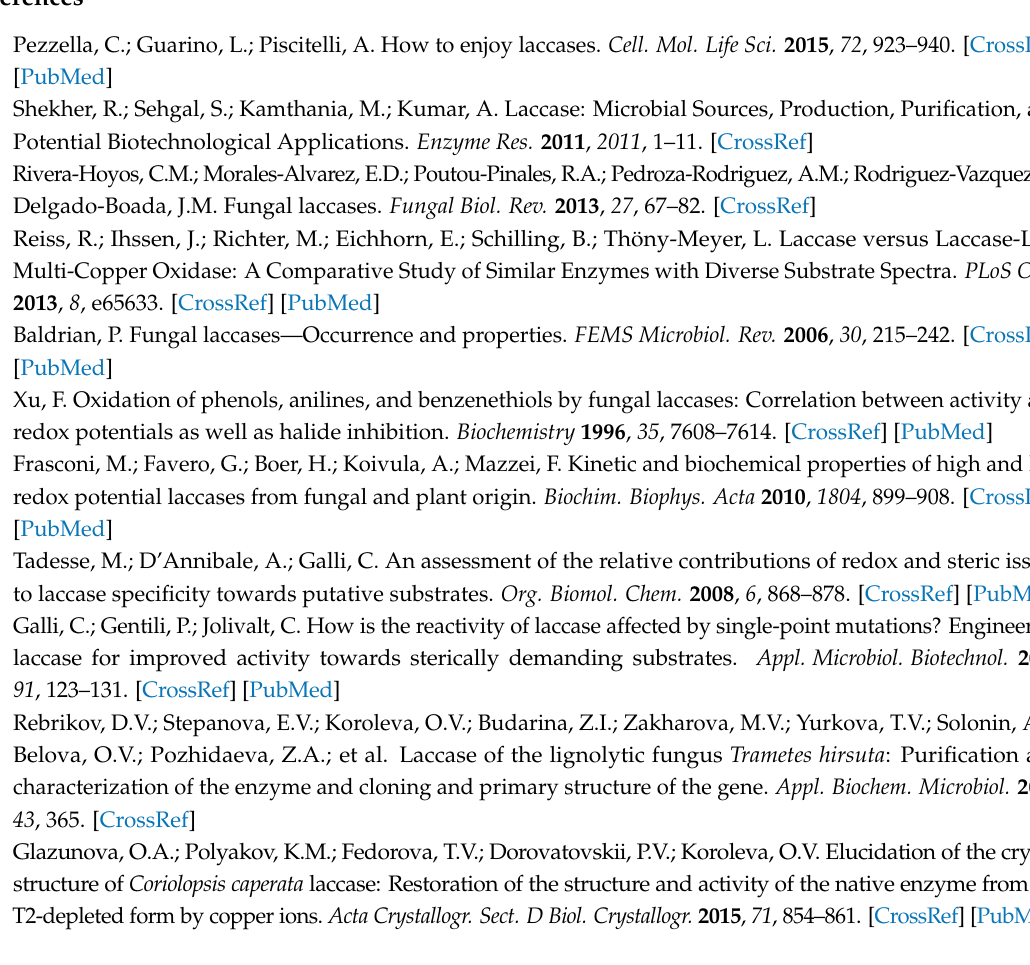
Table S1: Specific activity of laccases, Table S2: ClustalW alignment of the potential laccase substrate-binding region near T1 copper center. Figure S1: SDS-PAAG electrophoresis of purified laccases. Acknowledgments: This work was supported by the Russian Foundation for Basic Research [grant number 16-34-01355]. The work was carried out using the Shared Use Equipment Center for high precision measuring in photonics (ckp.vniiofi.ru,